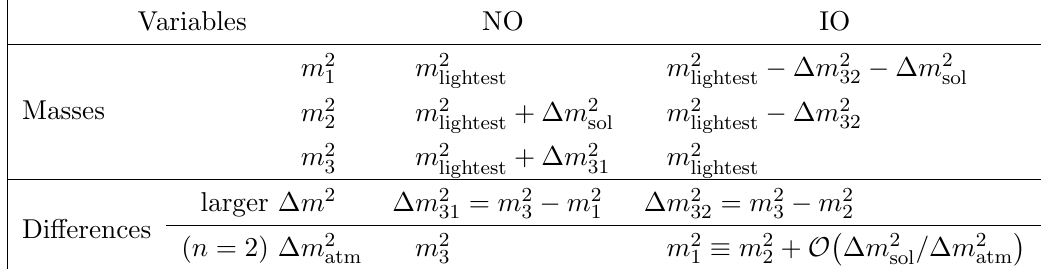
(cid:12) (cid:12) = (cid:12) m 2 3 (cid:0) m 2 1 (cid:12) . atm